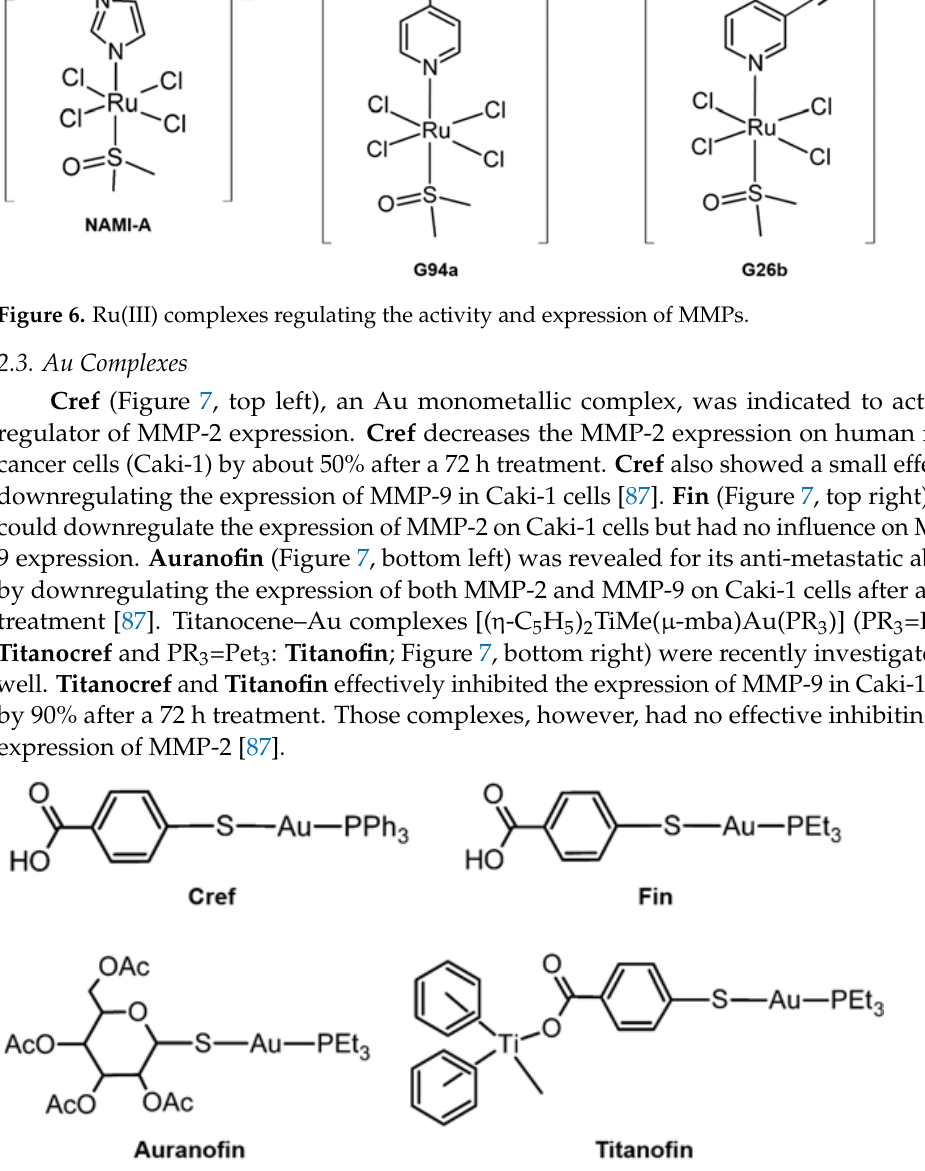
Figure 7. Au complexes for regulating the activity and expression of MMPs.